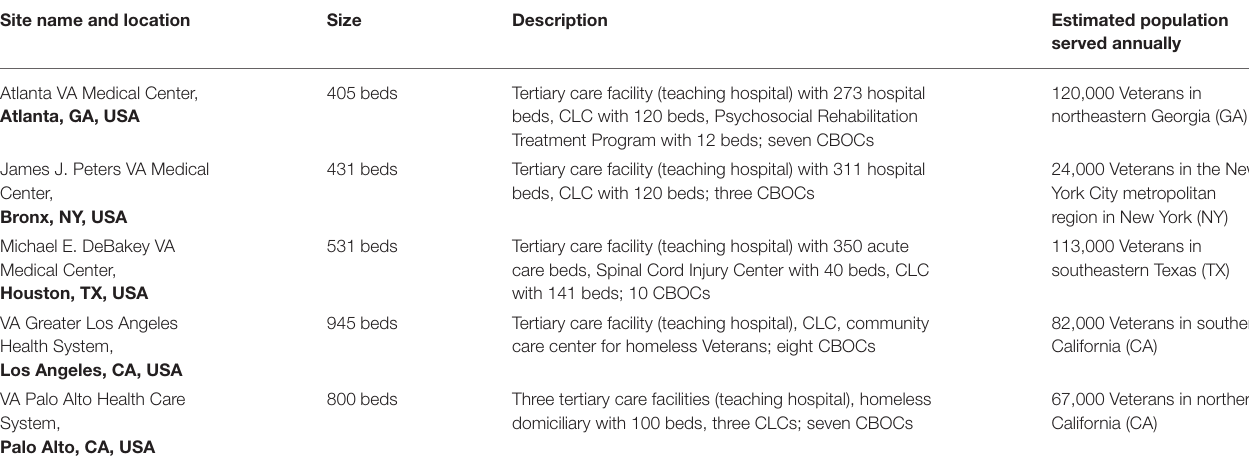
TABLE 1 | Selected characteristics of participating sentinel sites—Surveillance Platform for Enteric and Respiratory Infectious Organisms at Veterans Affairs Medical Centers (SUPERNOVA). Site name and location